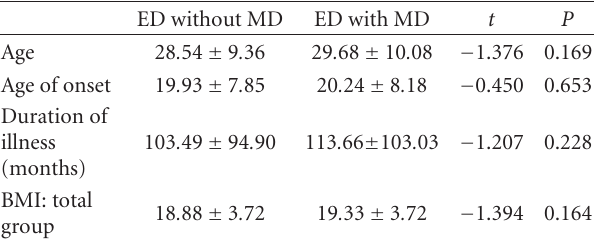
Table 2: Clinical features of the sample.